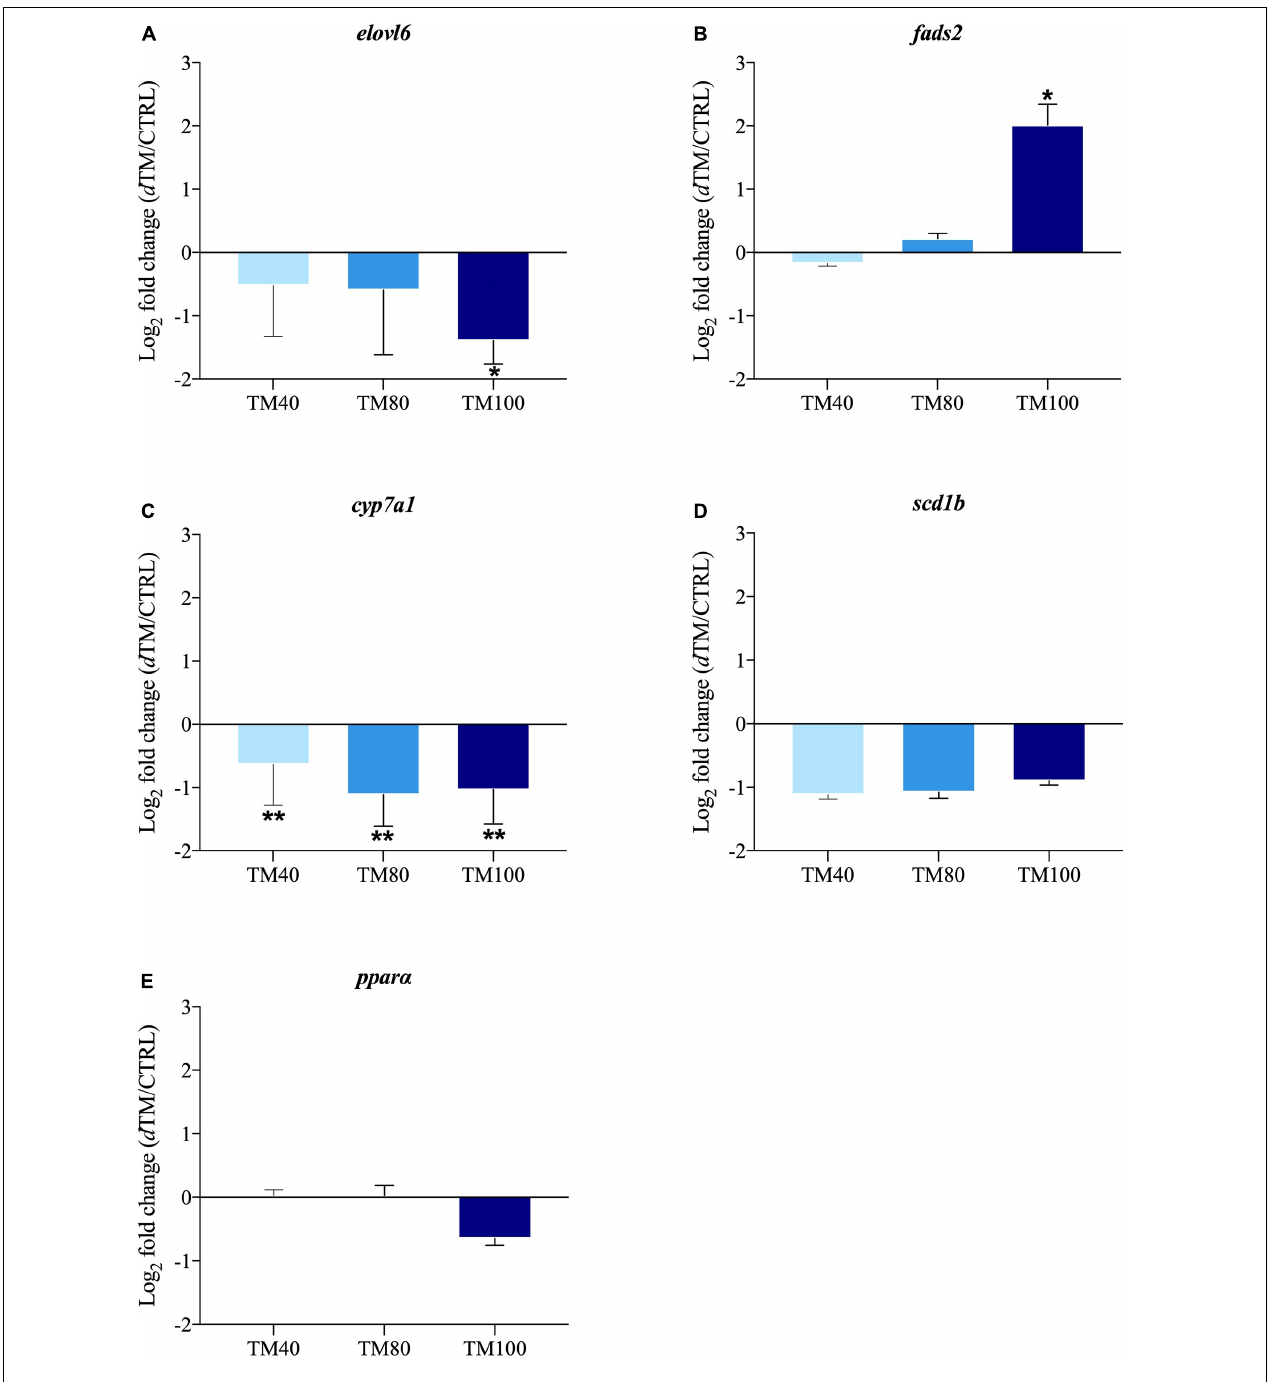
FIGURE 5 | Fold-changes ( d TM/CTRL) of differentially expressed genes in liver tissue: elovl6 (A) , fads (B) , cyp7a1 (C) , scd1b (D) and ppar α (E) . The asterisks indicate statistically significant differences (* p < 0.05; ** p < 0.01; t-student) between European sea bass fed d TM and CTRL diets. Values > 1 indicate up-regulated genes in d TM fish; values < 1 indicate down-regulated genes in d TM fish; n = 9 (3